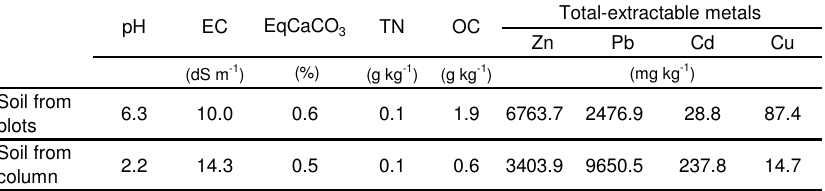
Average pH, Electrical Conductivity (EC), and Total Nitrogen (TN), Organic Carbon (OC), and Total Extractable Metal Contents in the Soil from Plots and Undisturbed Soil Columns